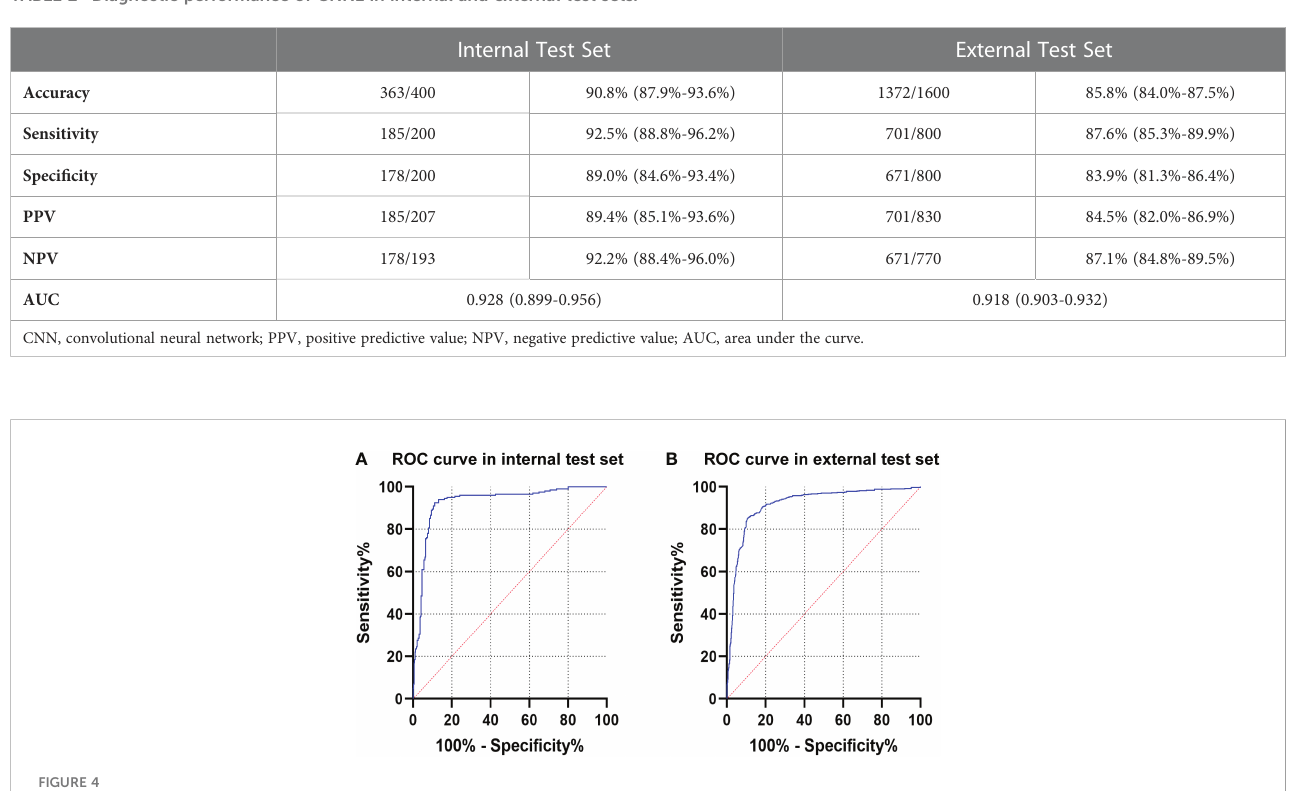
TABLE 2 Diagnostic performance of CNN1 in internal and external test sets.